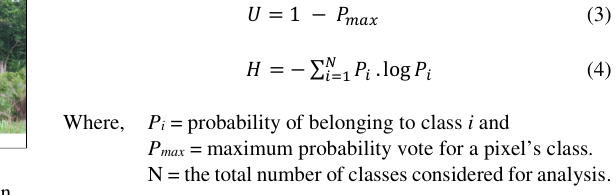
Figure 2. The range of vegetation land covers differ mainly in the density of woody biomass, which changes with season or phenological period (class acronyms are described in Table 2).